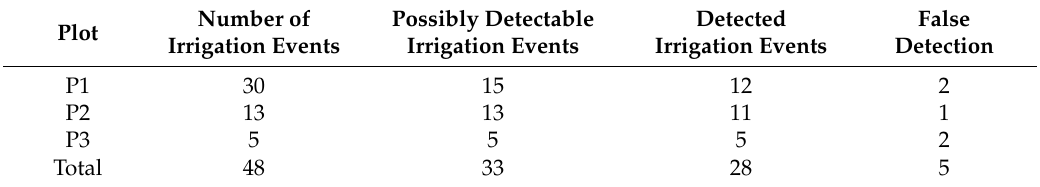
Detected False Irrigation Events Detection